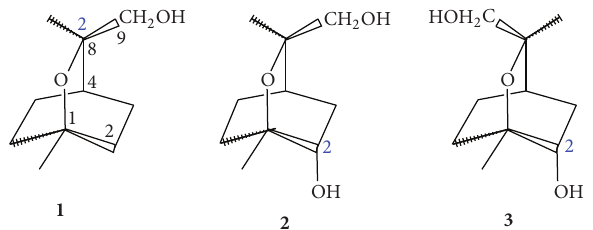
F 1: e structures of compounds 1 – 3 . e recently described [11] notation for indicating relative stereochemistry as an extension to the Natta projection convention proposed by Giulio Natta (1903–1979) is used and for which the “ 2 ” near to the C-2 and C- 8 atoms indicates that the number of stereoisomers present in the sample or under consideration is two. F 2: e absolute con�gurations of the two enantiomers, R - 4